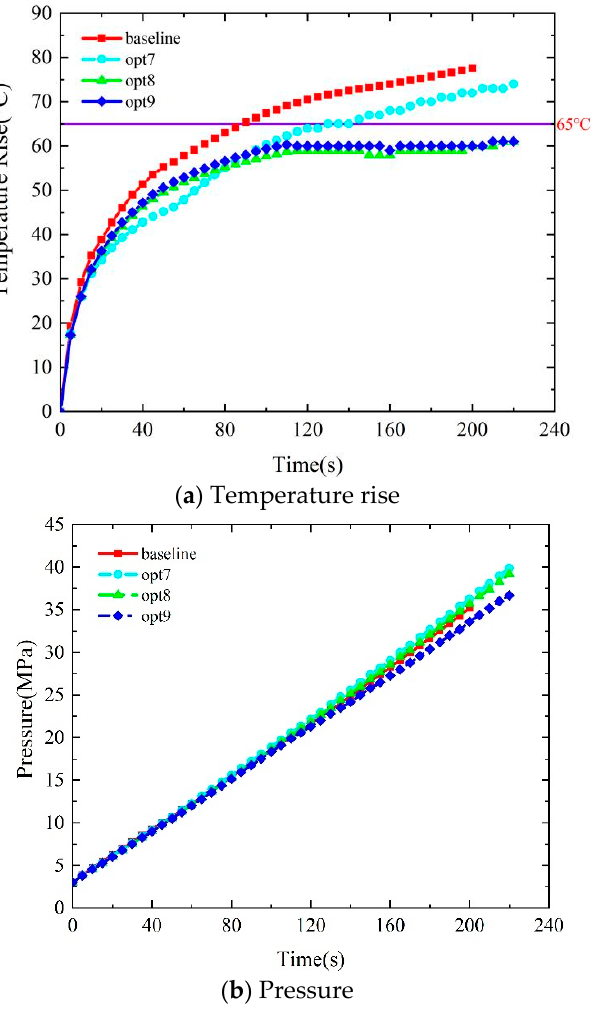
Figure 8. Temperature rise and pressure change in the cylinder of the benchmark and structural optimization schemes. Table 4. State of charge of the cylinder before and after optimization.